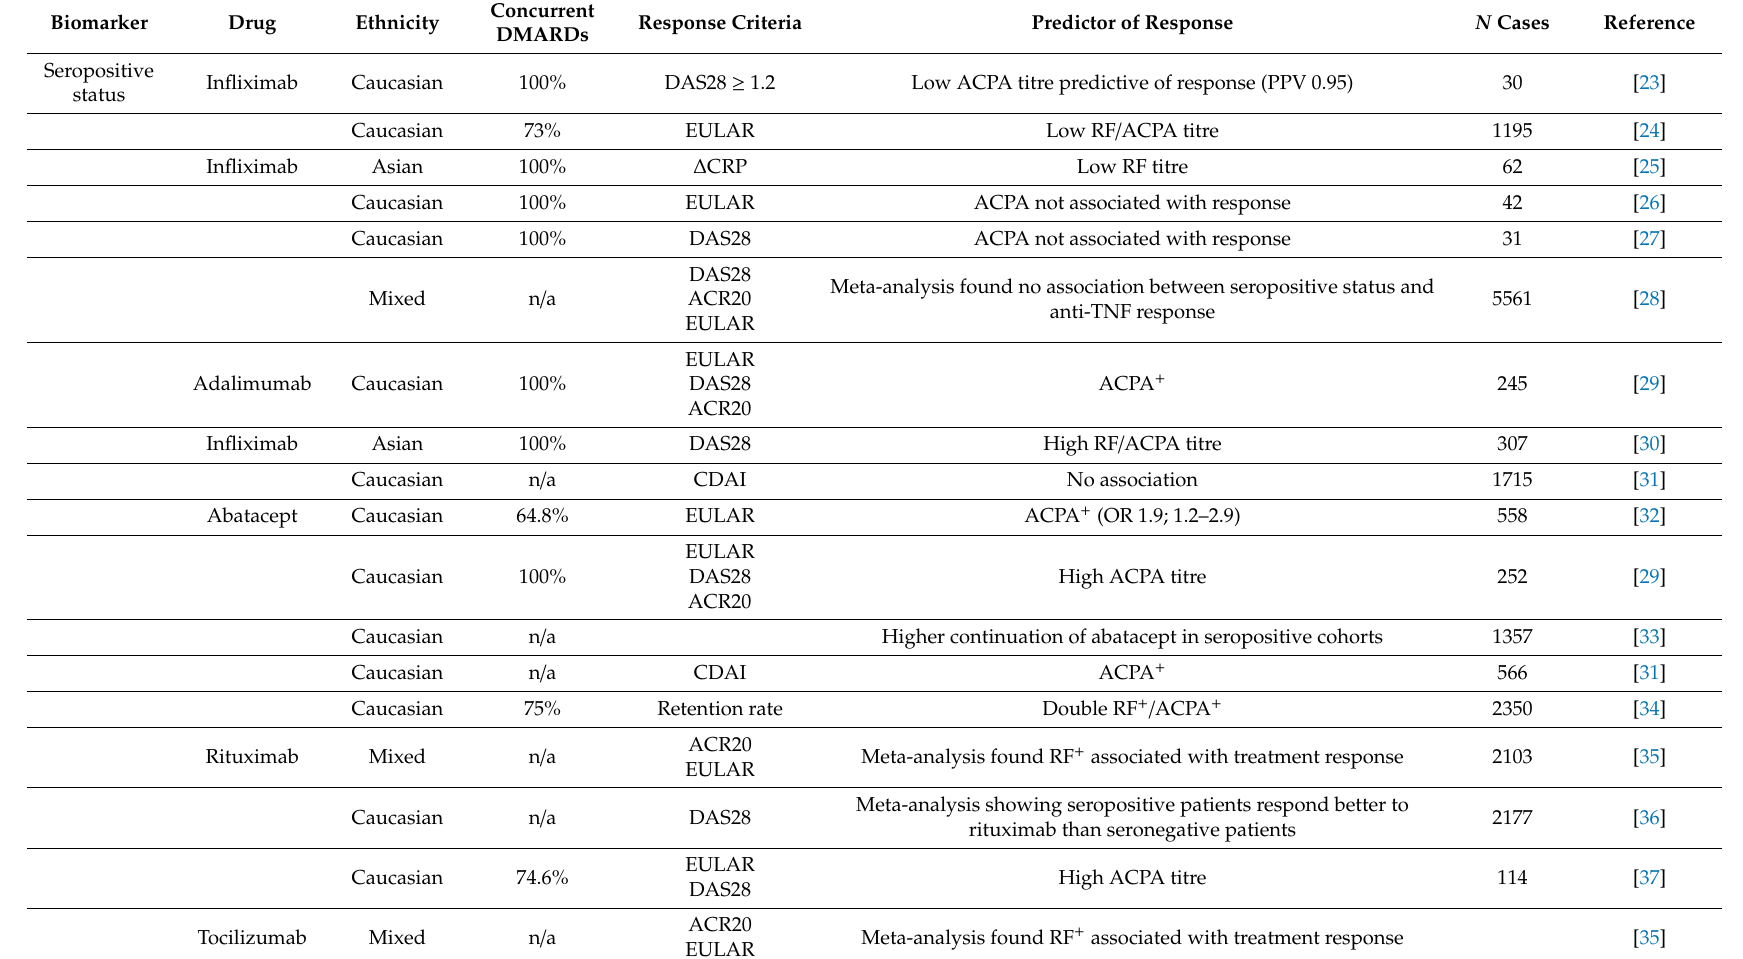
Table 1. Summary of the main studies investigating immune biomarkers as predictors of treatment